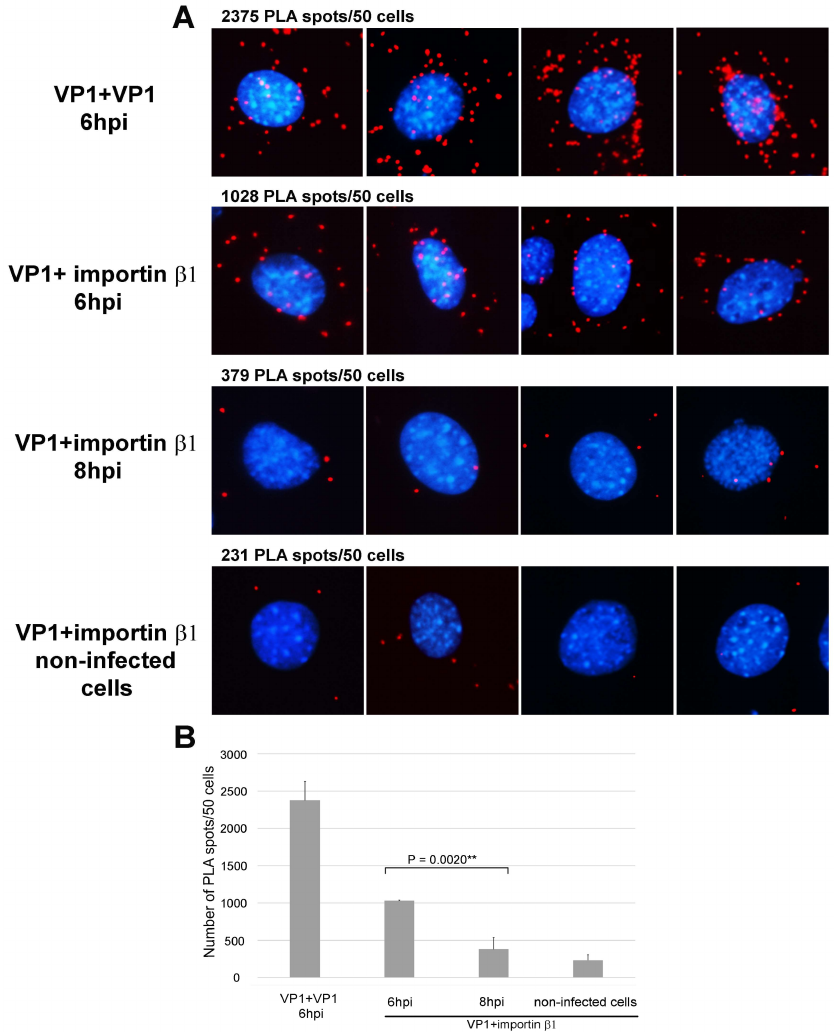
Figure 2. Proximity ligation assay of VP1 and importin β 1 at 6 and 8 hpi. ( A ) PLA assay was performed on 3T6 cells infected with MPyV (200 virus particles per cell), using primary mouse and rabbit antibodies against VP1 or mouse antibody against VP1 and rabbit antibody against importin β 1. Next, the oligoprobes tagged anti-mouse and anti-rabbit antibodies were used. Red spots represent the products of amplification after oligonucleotide ligation. DNA was stained by DAPI. As controls, the infected cells were stained with two antibodies (mouse and rabbit) against VP1 and non-infected cells were stained with anti-VP1 and anti-importin β 1 antibodies. At the top of each image, the average numbers of the PLA spots quantified in three independent experiments are presented (for each experiment 50 cells were analyzed). The pictures were taken 20 × magnification; ( B ) The graph represents the mean values of three independent experiments ± SD. Samples were compared by the Student’s t -test. p values are given and asterisks represent statistically significant differences (** p ≤